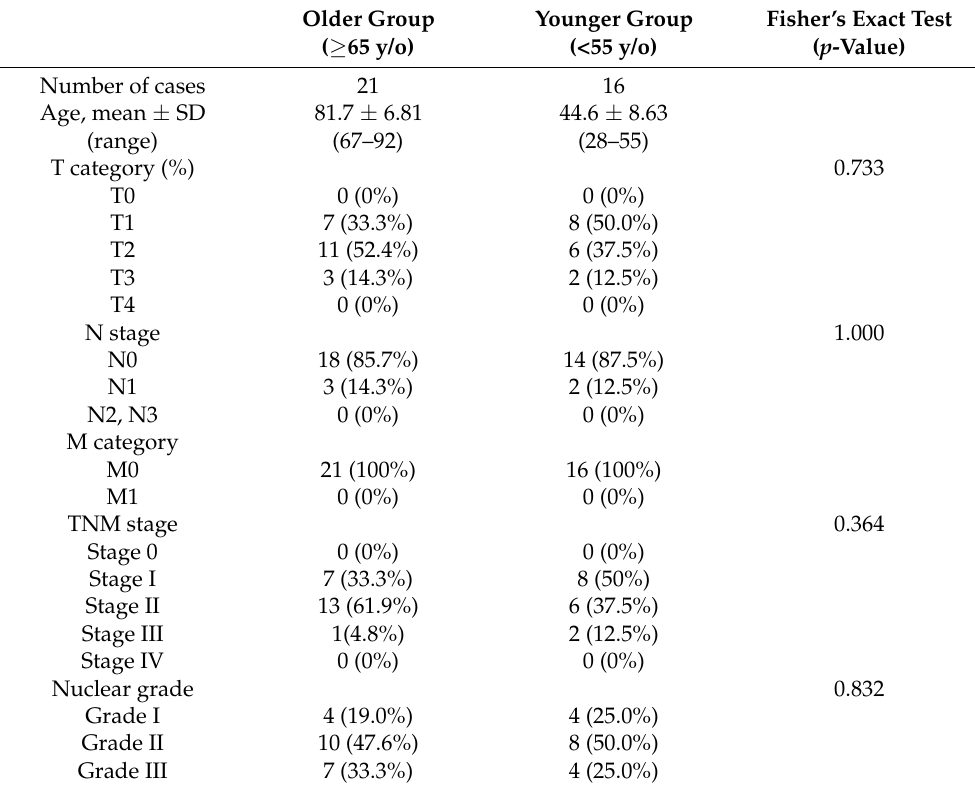
Table 2. Clinicopathological summary of breast mucinous